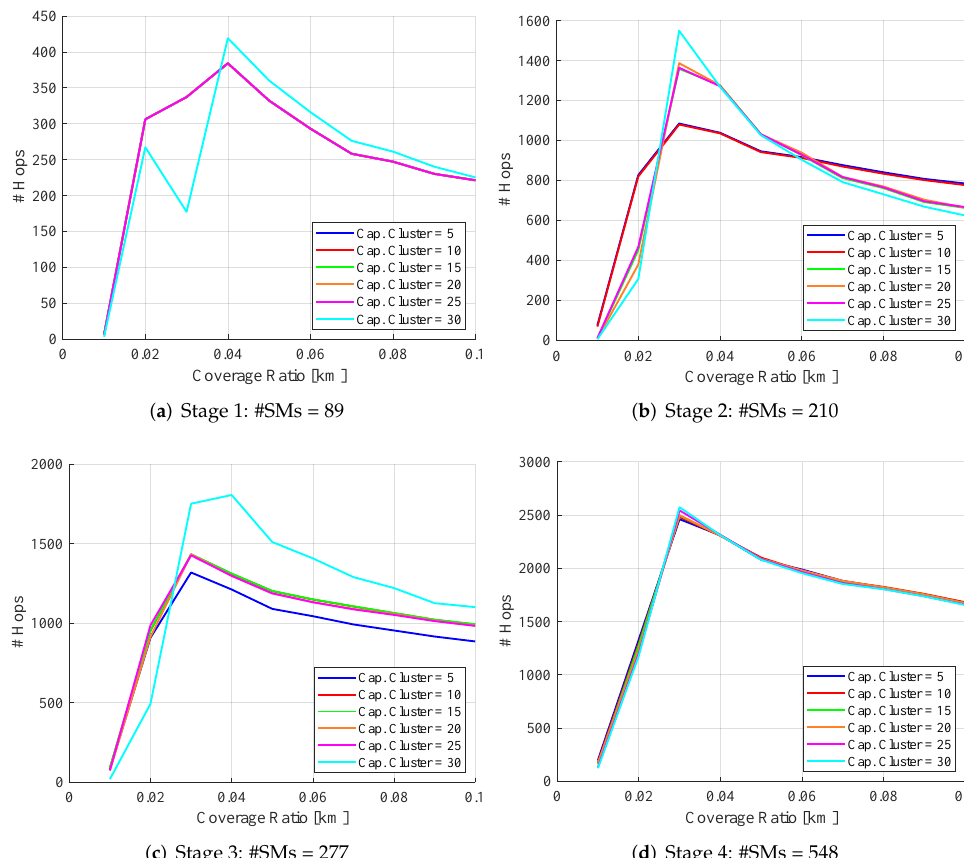
Figure 4. Variation in the number of hops as a function of coverage radius and cluster capacity of UDAPs.